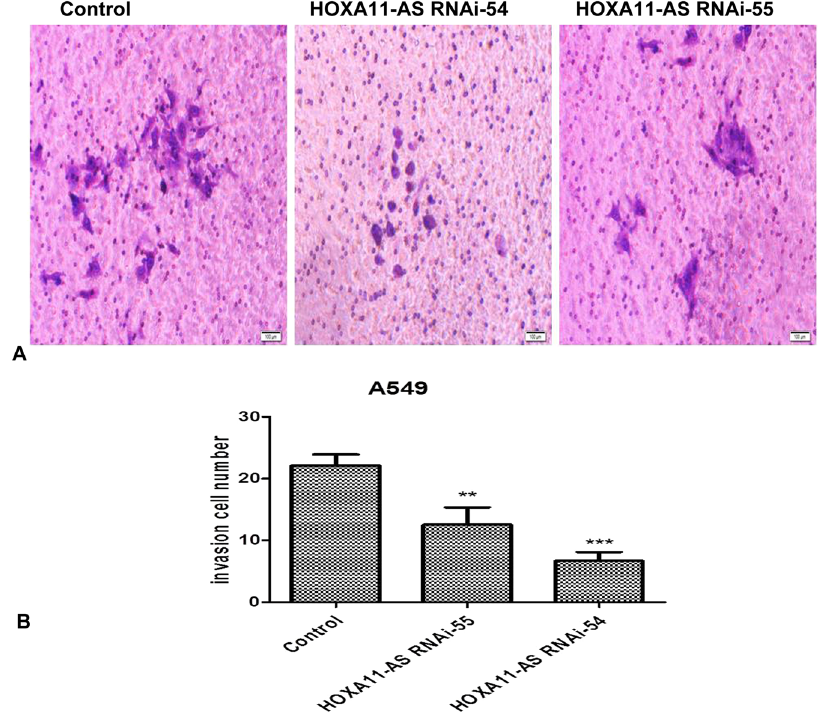
Figure 7. HOXA11-AS RNAi inhibited the invasion ability of A549 cells. (Note: control, lenti-control virus. ( A ) Qualitative Transwell migration assay of A549 cell invasion after knocking down HOXA11-AS. ( B ) HOXA11-AS RNAi-54 markedly inhibited the invasion ability of the A549 cells. ( ** P < 0.01, *** P <